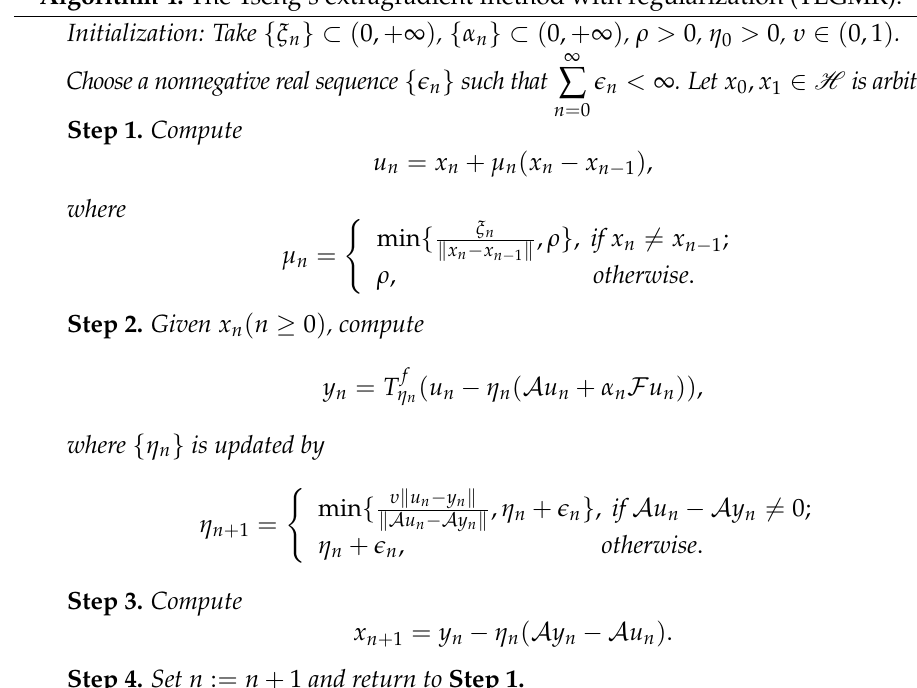
Algorithm 4: The Tseng’s extragradient method with regularization